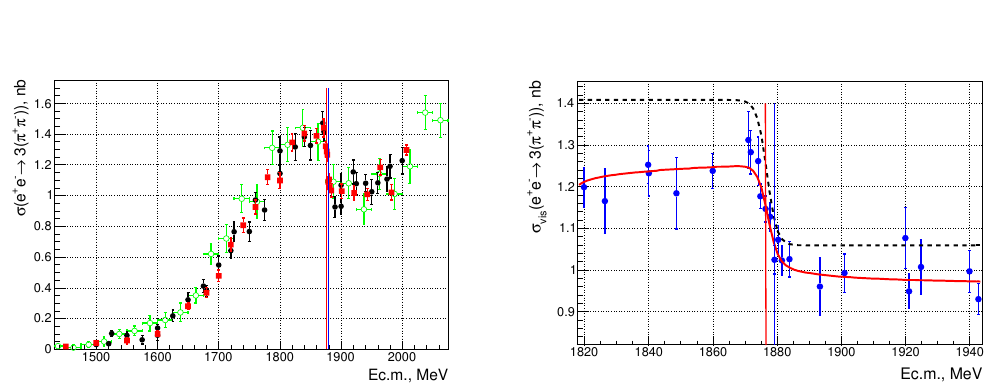
Figure 6. Preliminary results of the CMD-3 mea- surement of the e + e − → 3( π + π − ) cross section using 2017 data (red squares) in comparison with the previ- ous CMD-3 measurement [13] (black dots) and BaBar measurement (green open circles).